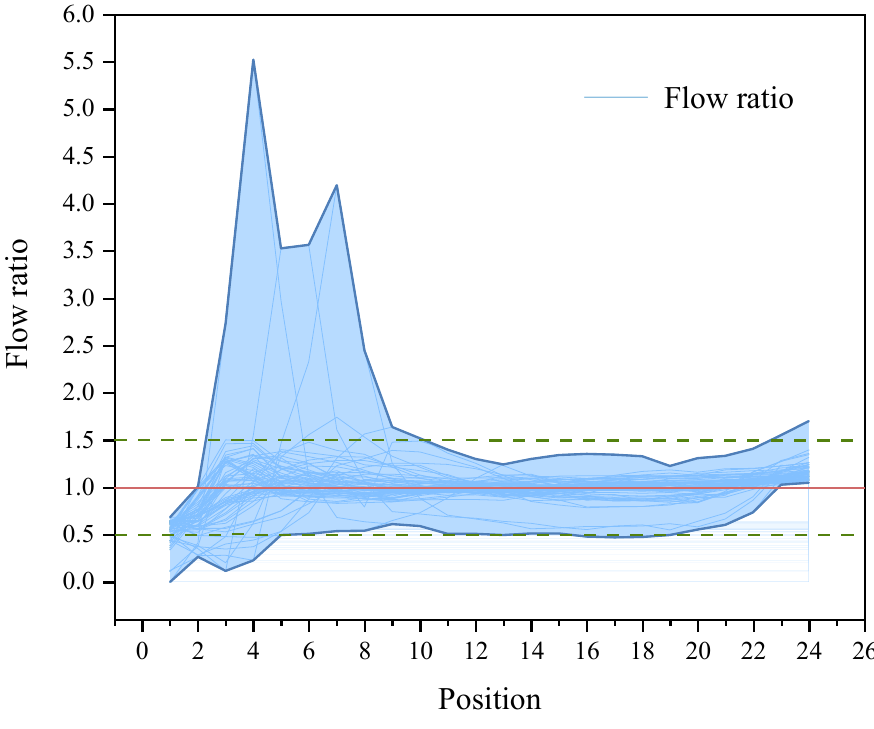
Figure 9. Flow distribution curve for the terminal device. Most of the flow regulation curves have relatively high flow rates for servers positioned downward because the deflector is deflected downward, changing the direction of the cold air to some extent and causing it to collect downward. Here, the three sets of angles (60, 0, 0), (0, 60, 0), and (0, 0, 60) have unusually high flow rates at the bottom, with the flow ratios of 5.5, 3.5, and 4.2 at the 4th, 6th, and 7th layer servers, respectively. The streamline plots for these three cases are shown in Figure 10. In all three cases, the terminal device has a better ability to improve the hot spots on the lower side of the rack. This is because the other two deflectors are 0 ◦ and the deflection angle of the open deflector is small, allowing a large amount of cool airflow to pour into the underside of the rack. This results in a greater cooling capacity underneath the rack. A comparison of the three shows that the further the open deflector is from the rack, the higher the peak position